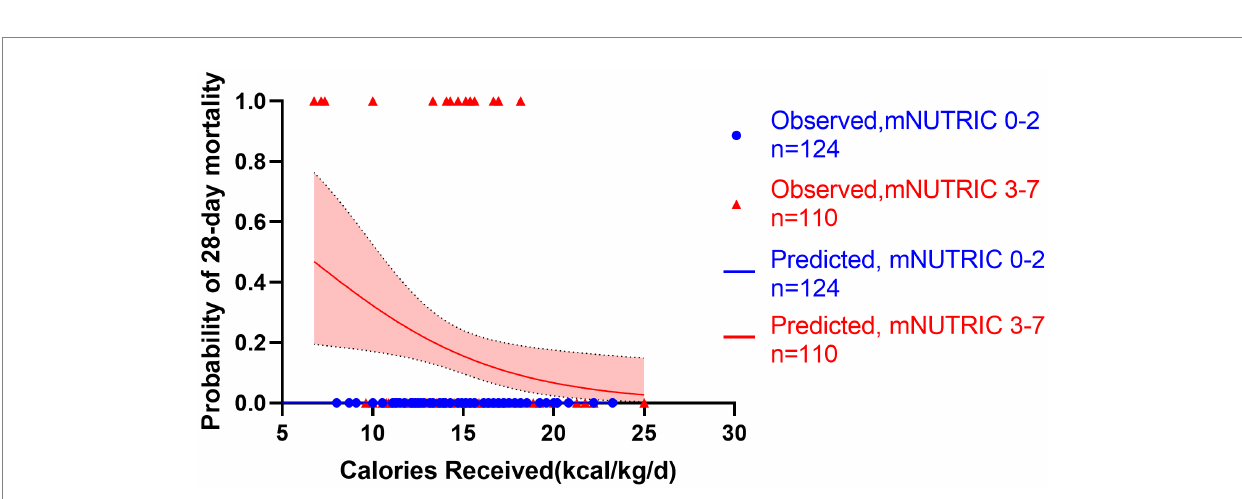
FIGURE 8 Predicted probability of 28-day mortality versus calories received by low mNUTRIC 0-2 (blue line, n = 124) versus high mNUTRIC 3-7 (red line, n = 110). Blue cycles represent the low NUTRIC score cases while red triangles represent the high NUTRIC score cases. Test for interactions were assessed by a logistic model including the NUTRIC score, the energy provision and their product (interaction). The test for interaction confirmed the association between energy provision and mortality is significantly modified by the mNUTRIC score (test for interaction p <